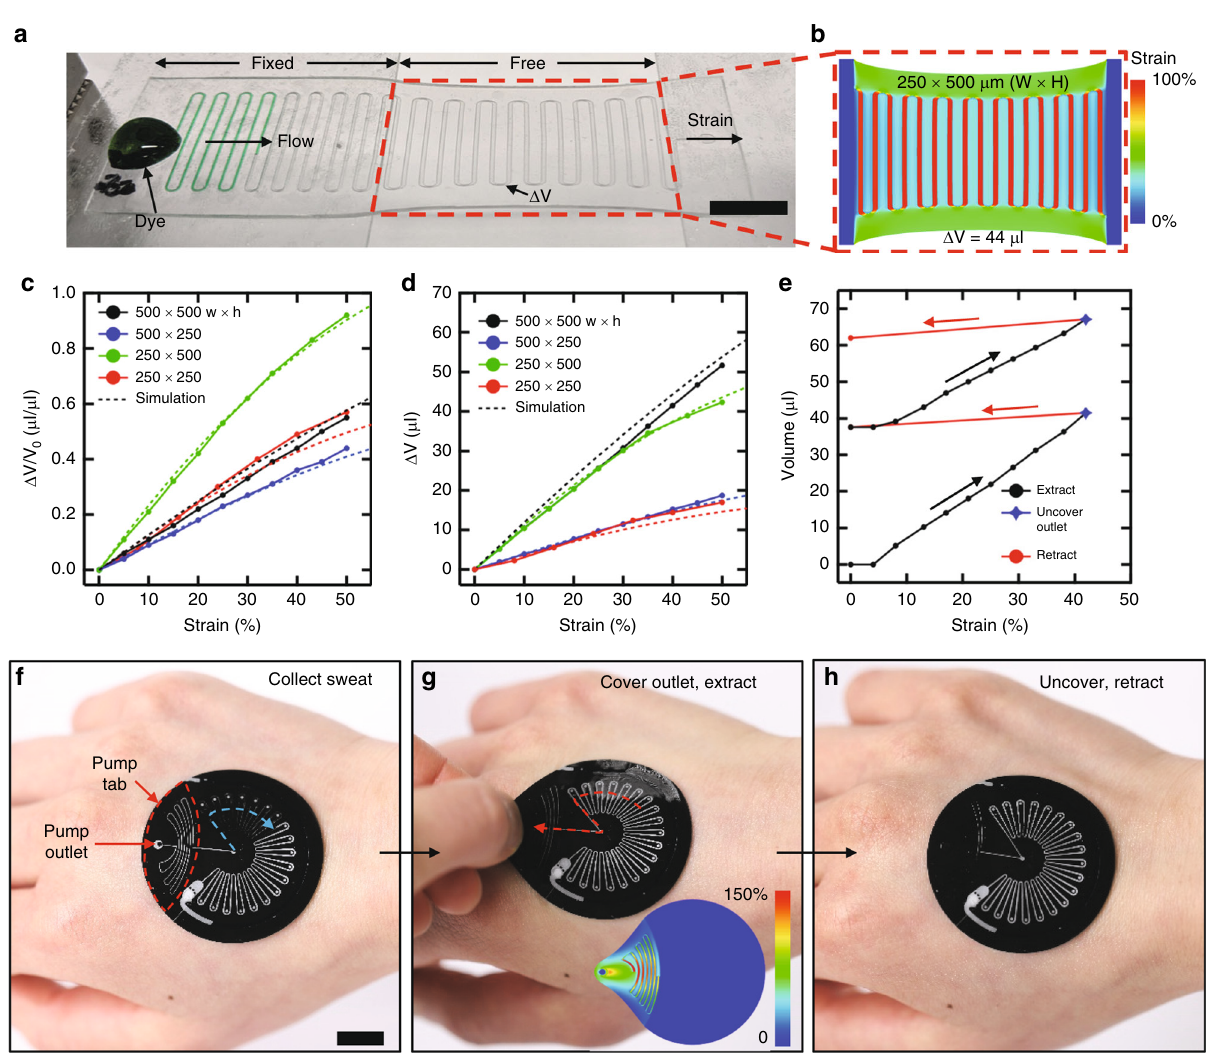
Fig. 4 Elastomeric, strain-actuated micro fl uidic purge system. a Demonstration of strain-induced suction in a serpentine microchannel embedded in PDMS to induce fl ow of a liquid dye ( Δ V = change in volume). Scale bar: 1 cm. b 3D fi nite-element analysis of embedded microchannels with a cross section of 500 × 250 µ m after straining to 50% indicates a capability to extract 44 µ l of liquid. c Volume extraction as a percentage of initial pump volume and dependence on cross-sectional dimensions. d Total volume extracted and dependence on cross-sectional dimensions. e Volume extracted from the collection channel during multi-cycles straining of a resettable device. Covering the outlet hole and applying lateral strain to the pull tab extracts sweat. Uncovering the outlet and subsequently releasing the strain purges the sweat from the device via the outlet. f Collected sweat in a resettable epi fl uidic device. Scale bar: 1 cm. g Covering the outlet and extending the pull tab extracts sweat into the pump channel. Inset: Strain distribution during 100% strain of the pull tab (7.75 mm lateral deformation). h Uncovering the pump outlet and releasing the strain purges the extracted sweat via the pump